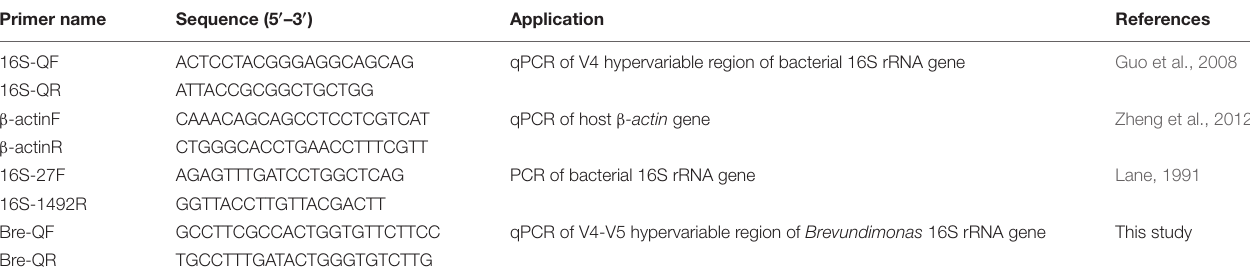
TABLE 1 | Primer utilized for gene analysis.